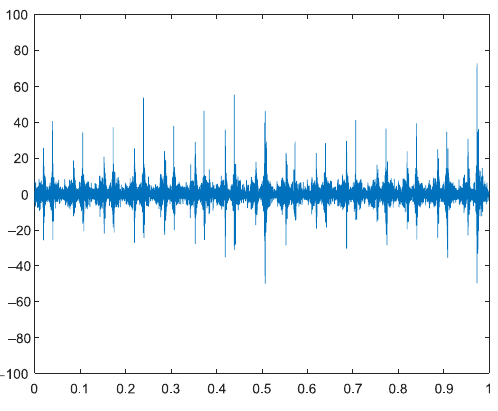
Figure 18. The waveform of input signal. The vibration characteristics of 1000 points were analyzed, and the waveform of the intercept signal is shown in Figure 19.